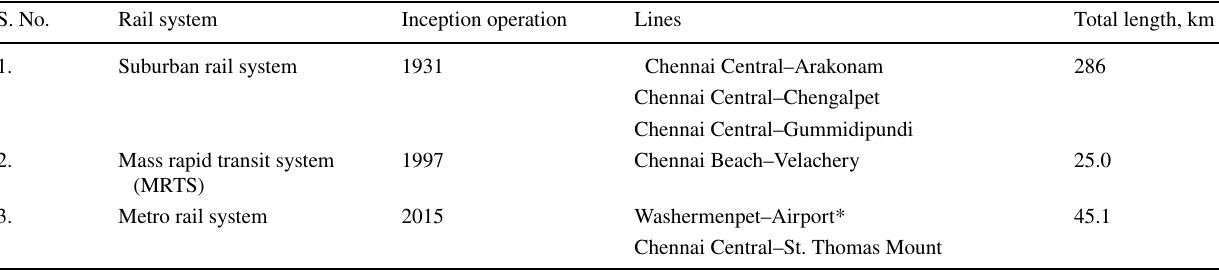
Table 2 Overview of rail systems in Chennai S.